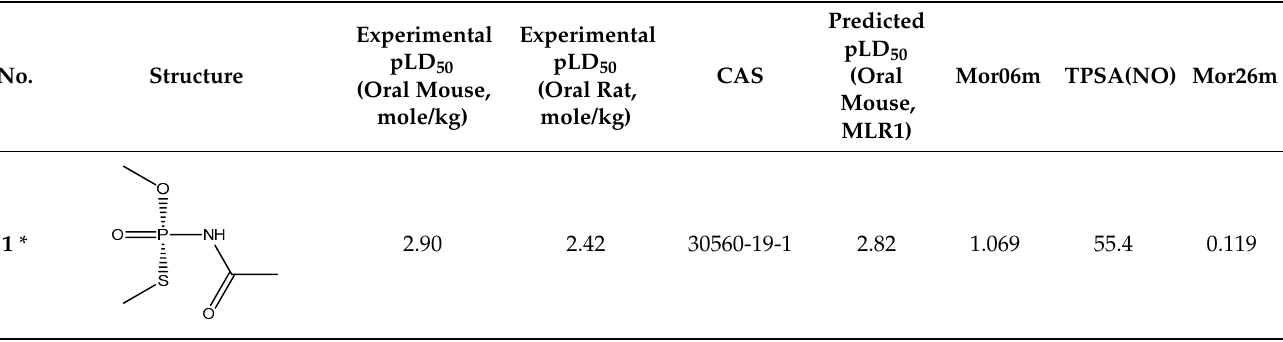
Table 1. The organophosphorous structures, the pLD 50 values derived from experimental oral acute toxicity data of mouse and rat, CAS number, the predicted oral mouse pLD 50 values model, and descriptors used in the best MLR1 model.